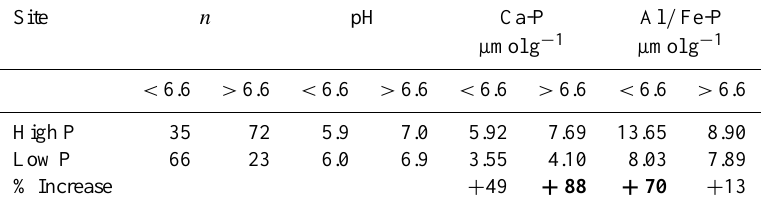
Table 2. Phosphorus fractions at different pH intervals in sediments of the high P site (Firth of Thames) and low P site (Saigon River delta).